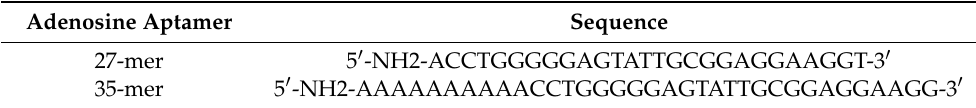
Table 1. DNA sequences used in this study.